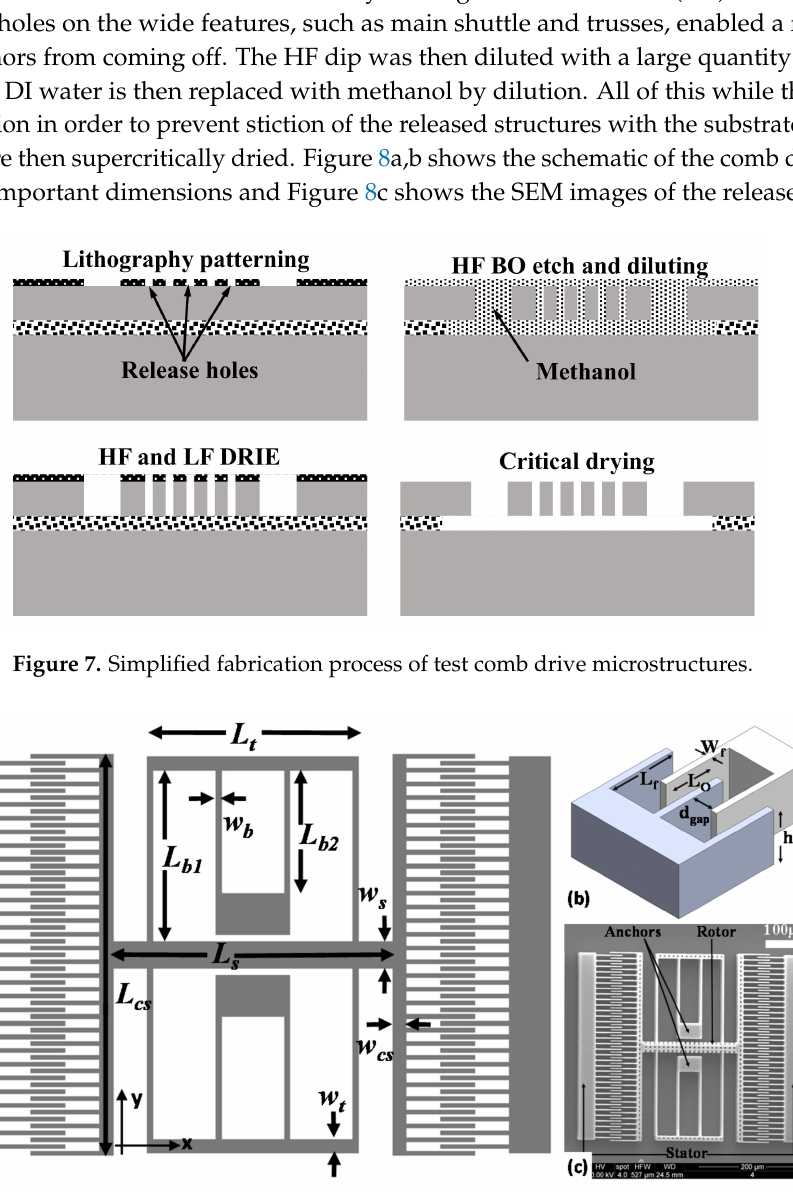
Figure 8. ( a ) Two-dimensional (2D) schematic of the COMB drive actuator with critical dimensions labeled. ( b ) 3D schematic of the COMB drive actuator with the rest of the critical dimensions labeled and ( c ) SEM photographs of the released COMB drive microactuator used for